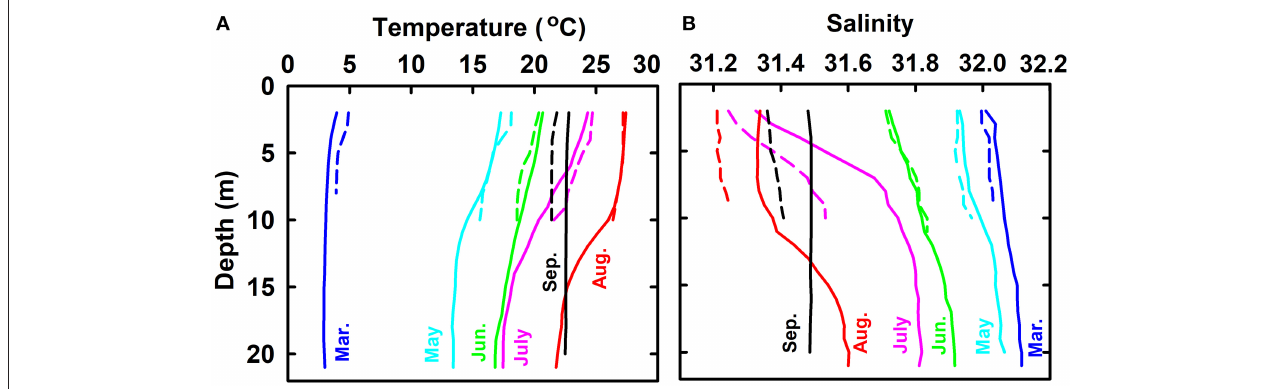
FIGURE 2 | Profiles of temperature (A) and salinity (B) from March to September in 2016. Solid lines stand for the bulk water mass whose temperature and salinity are the average of all sampling sites except for the sewage outlet. Dashed lines stand for the water at sewage outlet.